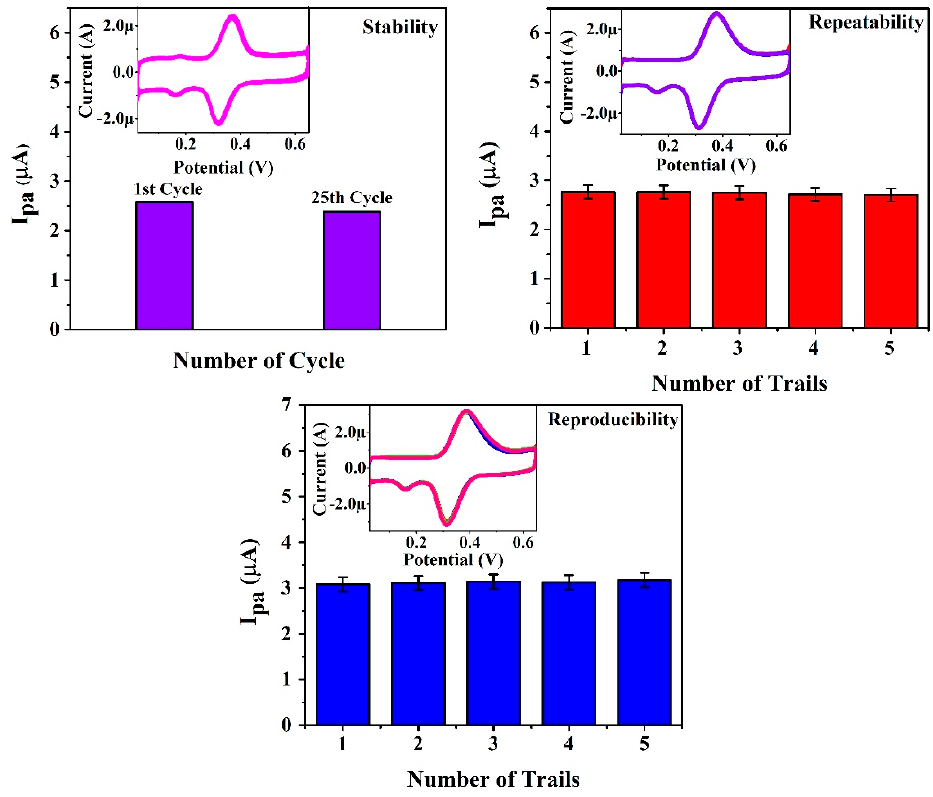
Figure 10. Results for P(PAN)LCNTPE stability, repeatability and reproducibility.